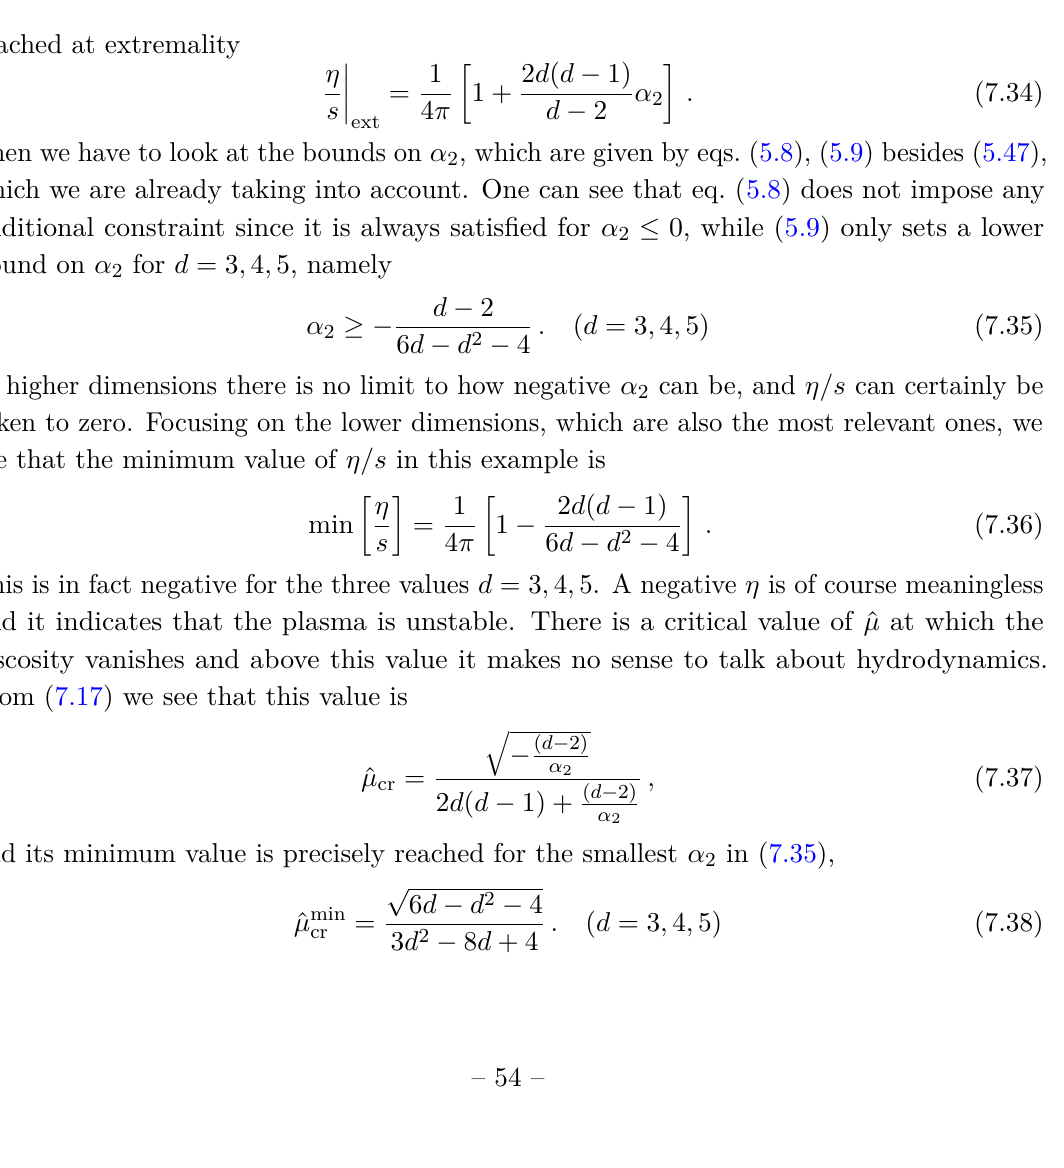
Figure 7. Shear viscosity over entropy density ratio as a function of the chemical potential in the case in which a 0 . We show the representative case λ = α 2 > Even when α satisfies all the physical constraints we have studied, it is possible to achieve η/s = 0 2 providing that the chemical potential is sufficiently